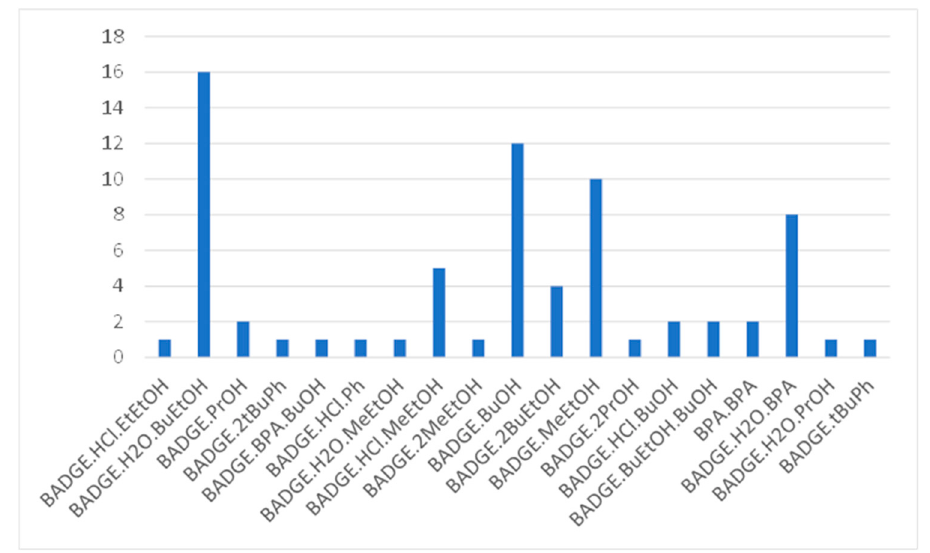
Figure 4. Incidence of BADGE derivatives..